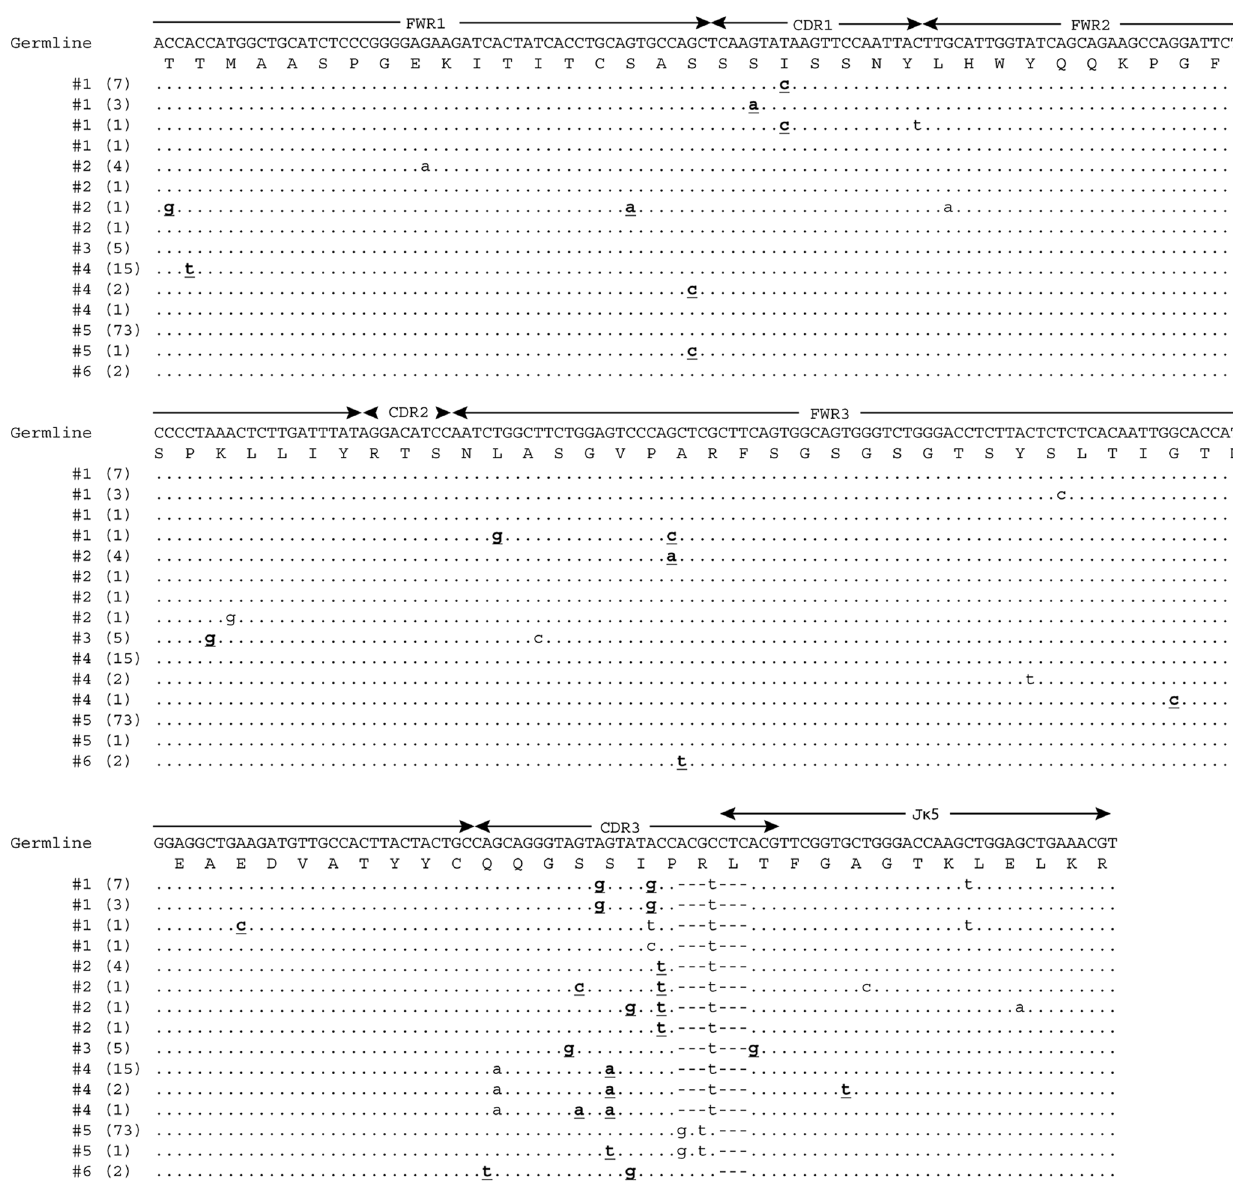
Figure 1. Representative IgAT analysis for V L clonotypes. Fifteen unique kf4/J k 5 DNA sequences were segregated into 6 clonotypes using IgAT. Germline sequence was obtained by manually juxtaposing the available germline kf4 gene (GenBank:AJ231229.1) and J k 5 (GenBank:V00777.1) sequences. Numbers on the left side of the aligned sequences indicate the clonotypes determined by IgAT. The numbers in parentheses indicate the number of replicates that were isolated for each unique sequence. Sequences marked with same number are potentially clonally related. Sequence delineation is based on the IMGT system. Replacement mutations are shown in bold underlined font.